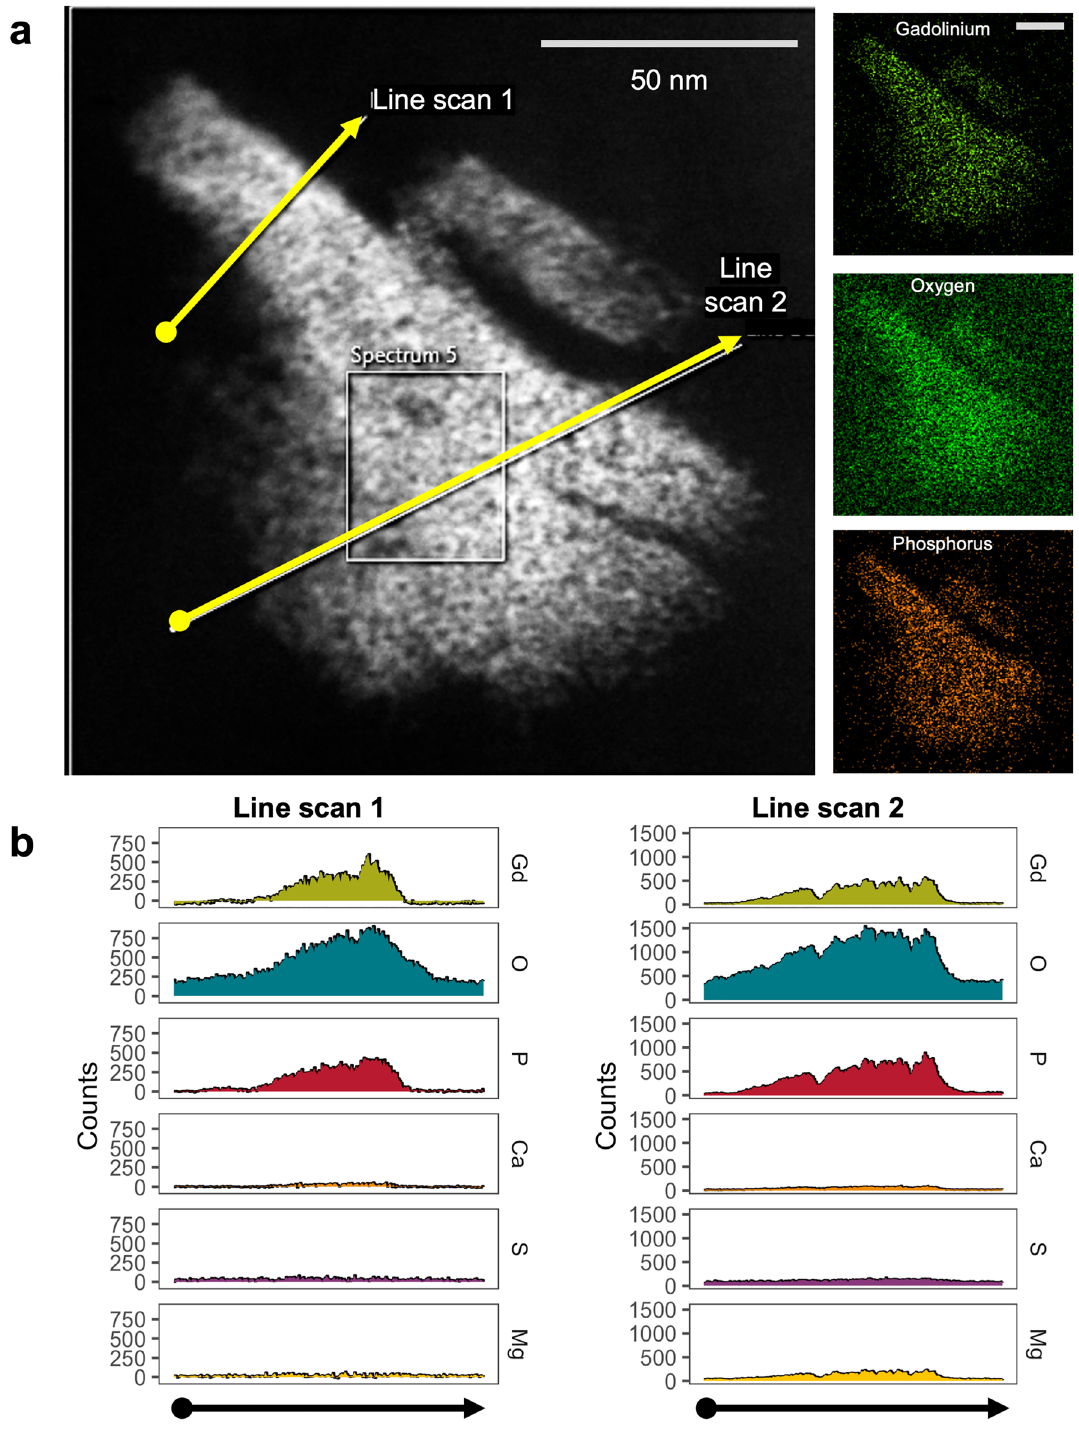
Figure 8. STEM XEDS line scanning through a nanoparticle found in human kidney. ( a ) Dark-field scanning transmission electron microscopy image of a nanoparticle found in human kidney. Insets depict 2D XEDS mapping of the precipitate for gadolinium, oxygen, and phosphorus. Calibration bars = 50 nm. ( b ) XEDS line scan data through the nanoparticle in A showing background corrected X-ray counts as a function of distance along the line scan. JEOL NEOARM (JEM ARM200F), probe aberration-corrected STEM with dual EDS X-ray analysis